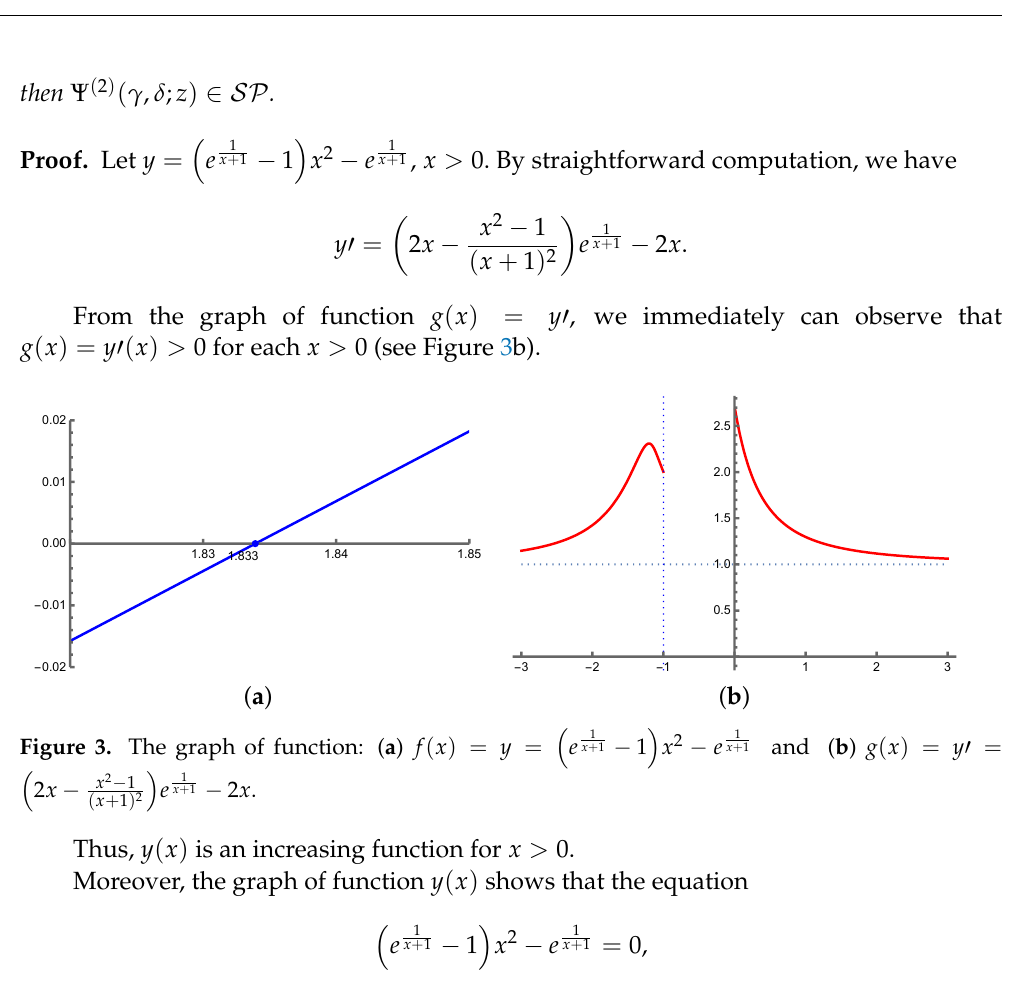
(cid:16) (cid:17) e 1 x + 1 − 1 x 2 − e 1 x + 1 and ( b ) g ( x ) = y (cid:48) =